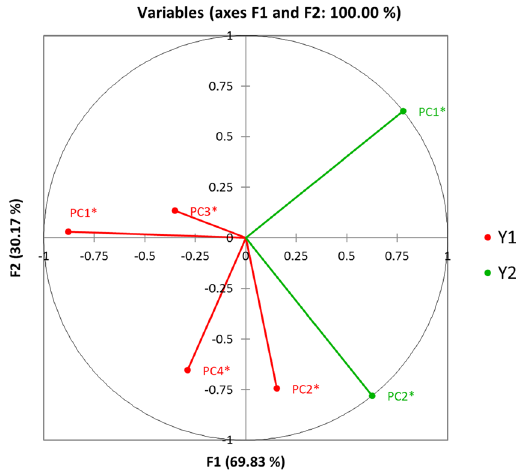
Figure 4. Canonical correlation analysis (CCorA) plot revealing associations between the PC scores vectors arising from (1) total lipoprotein triacylglycerol-CH 3 function-normalised 1 H NMR triacylglycerol resonances (PCs 1–4), and (2) total triacylglycerol concentration-normalised clinical chemistry-determined total, LDL- and HDL-associated cholesterol concentrations (PCs 1 * and 2 * ). Information regarding the predictor variables loading on each set of PCs is provided in section 2.6. Y1 and Y2 represent scores vector datasets arising from the separate 1 H NMR and clinical chemistry datasets